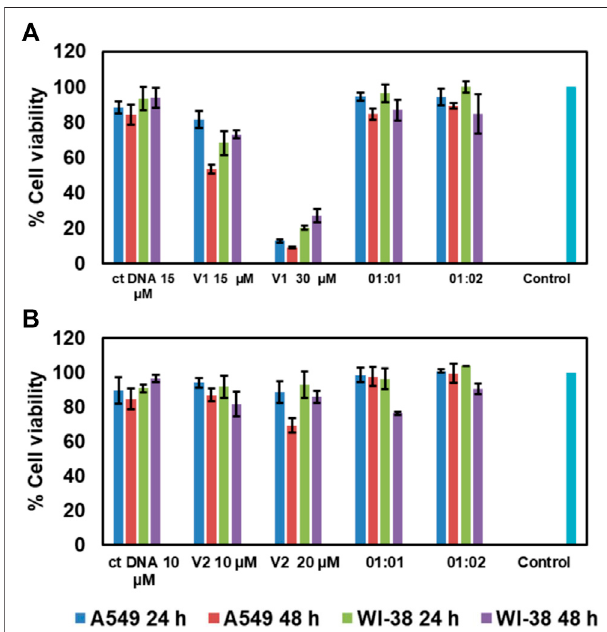
FIGURE7| CellviabilityassayofA549andWI-38cellsinthepresenceof (A) TPE-V1 /CT-DNA and (B) TPE-V2 /CT-DNA assemblies and their control experiments after 24 and 48 h